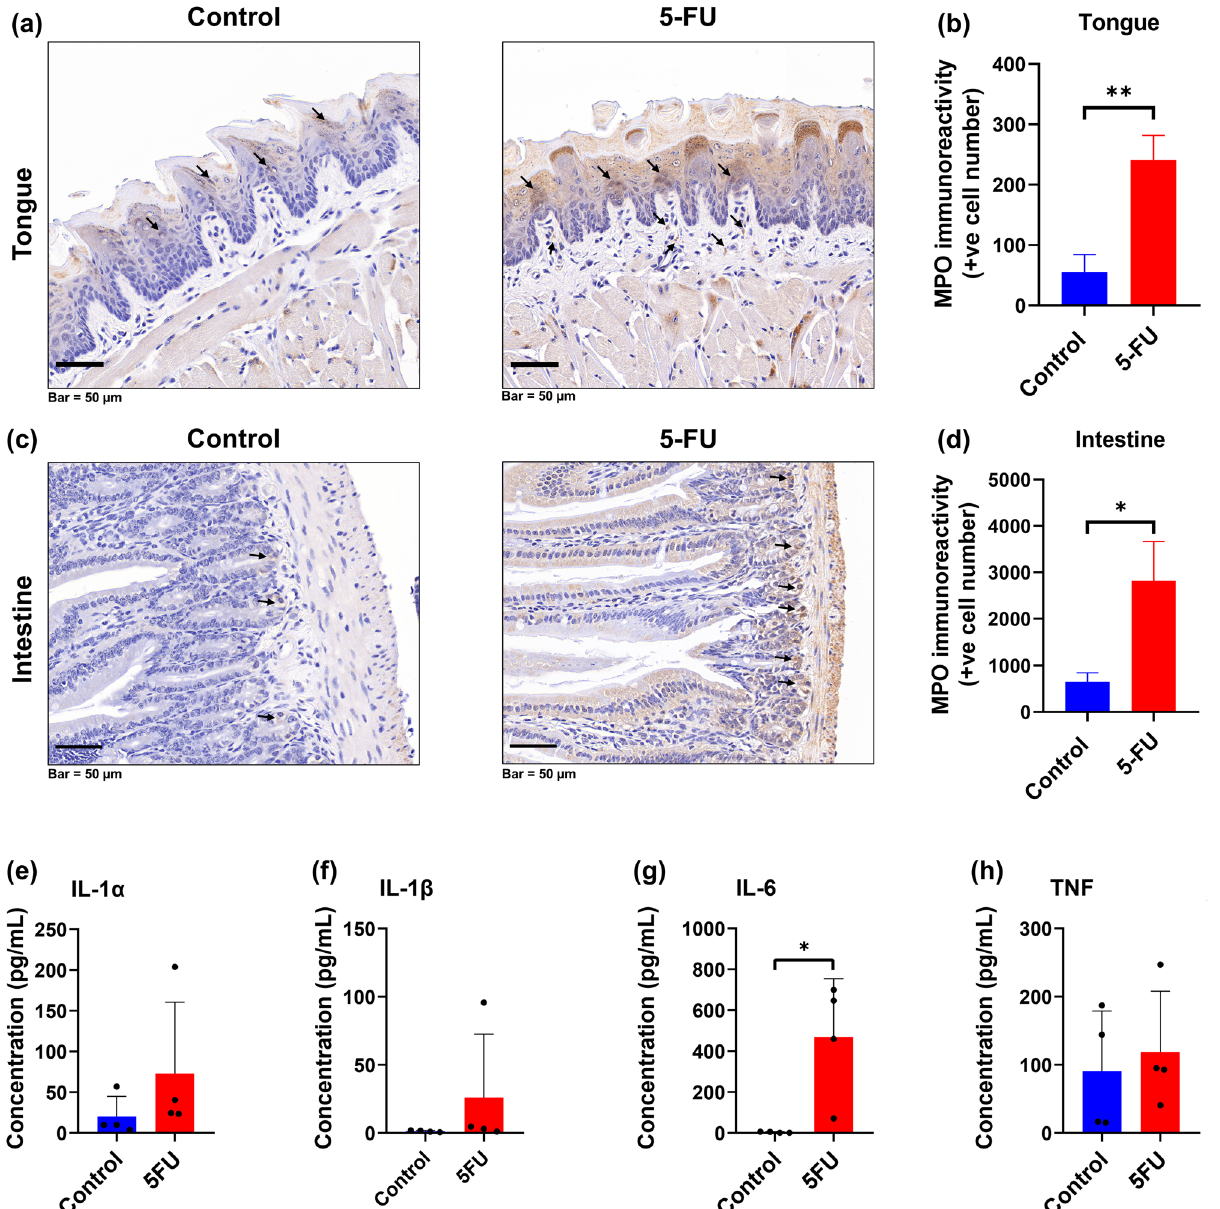
Figure 5. Effect of 5-FU on MPO levels in tongue and jejunum tissues, and inflammatory cytokynes levels in serum. Immunohistochemical analysis for MPO expression. Mice received 5-FU Intravenously (i.v.), withtongue and jejunum were excised at sacrifice on day 14. MPO immunolabelled cells in tongue and intestinal mucosal sections were counted. MPO positive cells were counted in tongue mucosa of each section from three different transverse sections/tongue of three representative mice/group. MPO positive cells in the intestine were counted from twelve full villus per jejunum section, four intestinal sections per mice, with three representative mice per group. ( a ) Representative microphotograph showing immunohistochemical staining for MPO in tongue mucosa of C57BL/6 mice (images at magnification X20). MPO positive cells were detected in the epithelial and lamina propria area (black arrows; bar indicates 50 μm). ( b ) Graphical representation of the number of MPO positive cells/tongue. Data are expressed as mean ± SD. ( c ) Representative microphotograph showing immunohistochemical staining for MPO in small intestine of C57BL/6 mice (images at magnification X20). MPO positive cells were detected in the tunica mucosa and submucosa area (black arrows; bar indicates 50 μm). ( d ) Graphical representation of the number of MPO positive cells/intestine. Data are expressed as mean ± SD. Levels of pro-Inflammatory cytokine proteins, IL-1α ( e ), IL-1β ( f ), IL-6 ( g ), and TNF ( h ), were determined in serum at day 14. Data are expressed as mean ± SD. * P < 0.05, ** P <